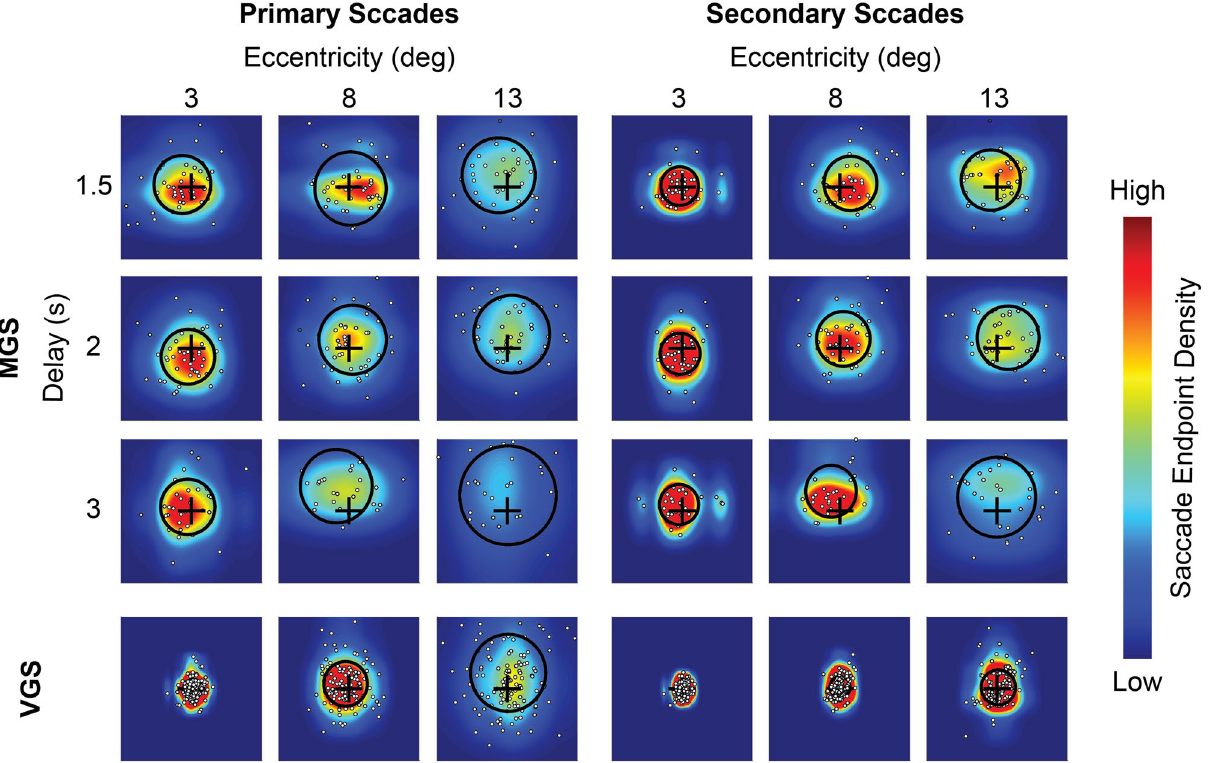
Figure 3. Saccade endpoint distribution across eccentricities and delays for one typical subject in Experiment 1. Heat maps display the saccade endpoint distributions that are ± 3° of visual angle around the target location for the primary and secondary saccades during the MGS and VGS tasks. The target position is marked by a black cross at the center of each heat map. The color scale indicates the increasing density of the saccade endpoints (from cool to warm colors). The small white dots mark the saccade endpoints of the individual trials. The black circle in each heat map shows the calculated systematic and unsystematic errors, with the distance between the center of the circle and the black cross representing the shift of the mean saccade endpoint position from the target (systematic error) and the radius representing the saccade endpoint variability across trials (unsystematic error).